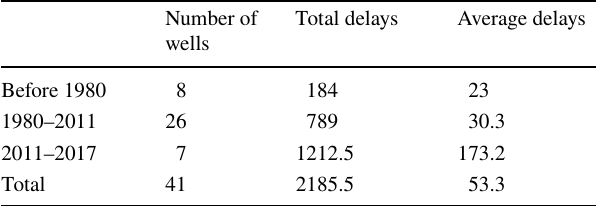
Table 1 The average drilling delays/deviation in Kupal oilfield for the Number of